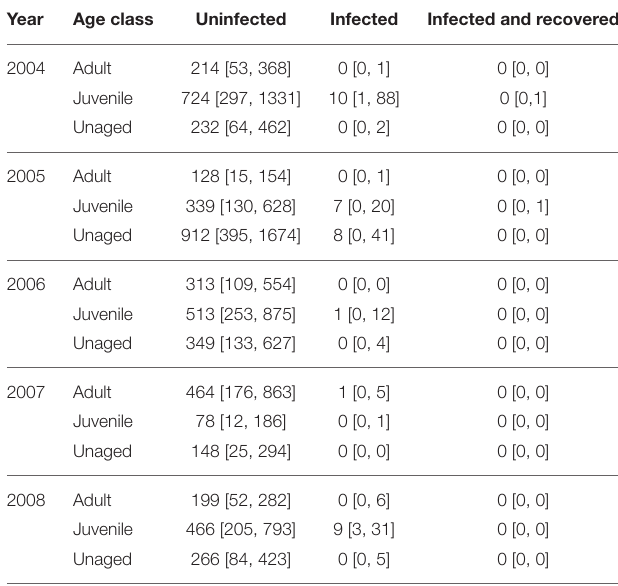
TABLE 1 | Summary of the expected number of dispersal events for the autumn migratory seasons 2004–2008 broken down by age